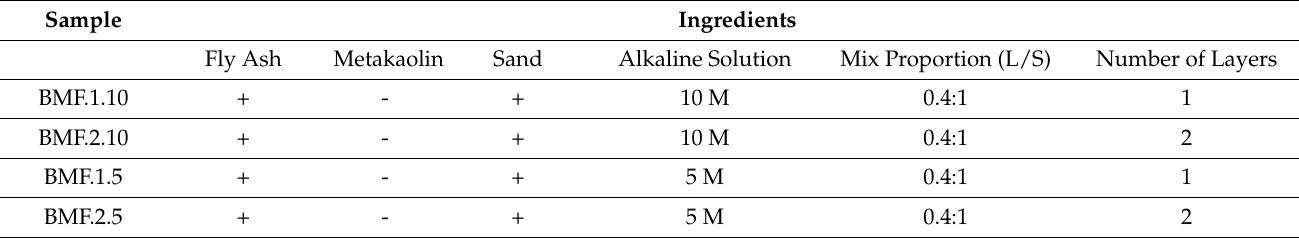
Table 6. Composition of prepared geopolymer composites reinforced with basalt